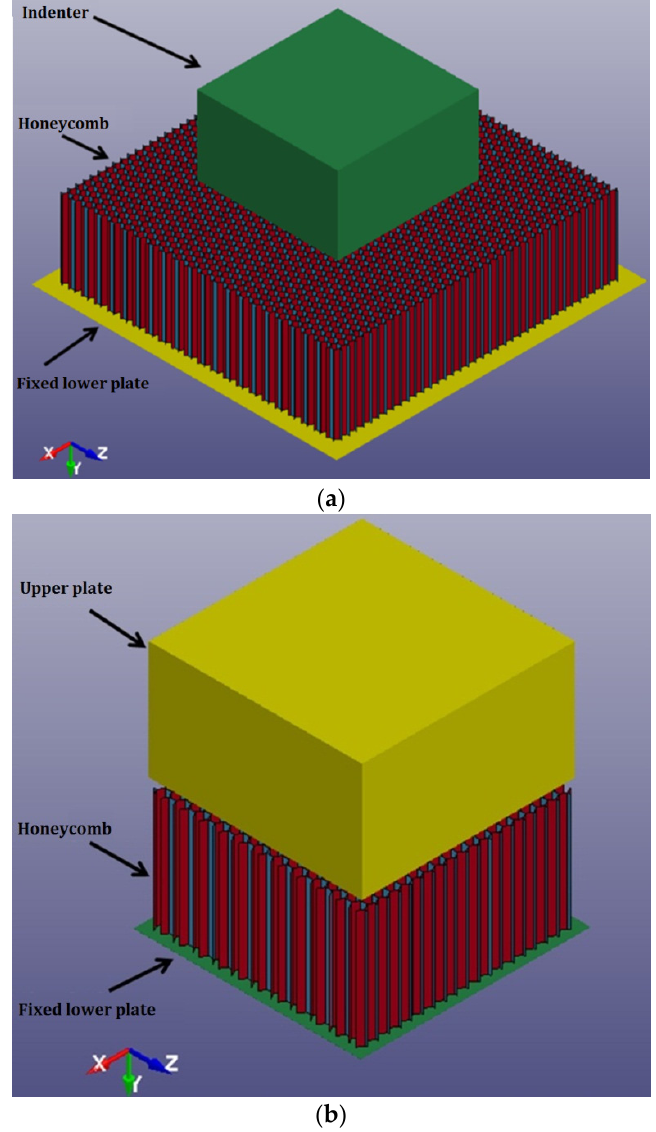
Figure 1. Typical FE models of honeycomb H31: ( a ) indentation; ( b ) compression.